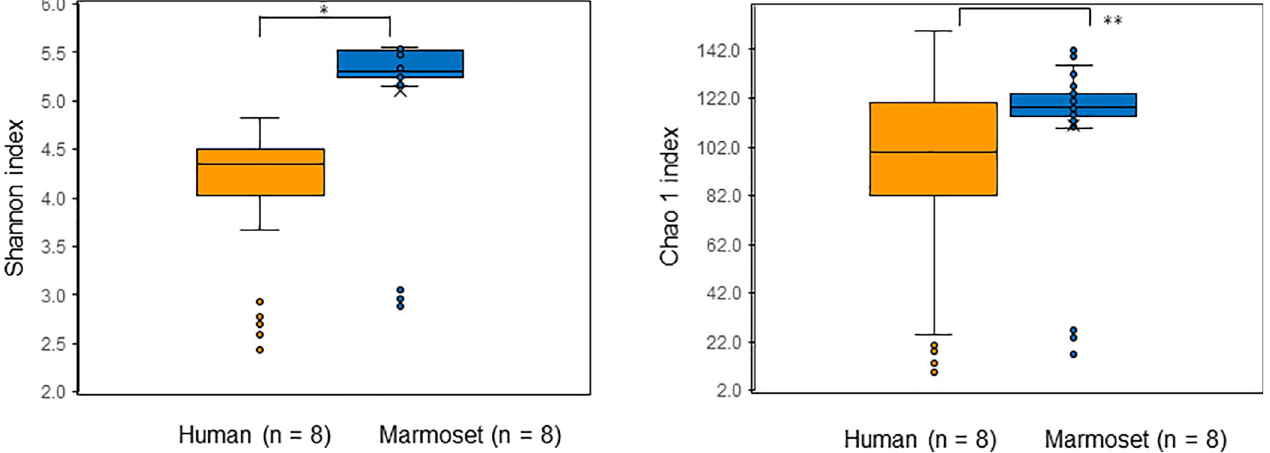
Fig 1. Diversity analysis for humans and marmosets based on the bacteria abundance distribution for each individual at OTU level. (A) Shannon diversity. Vertical axis indicates the diversity in number of distinct OTUs. (B) Chao 1 index diversity. Vertical axis indicates the richness estimates in number of distinct OTUs. � : p < 0.0001, �� : p =